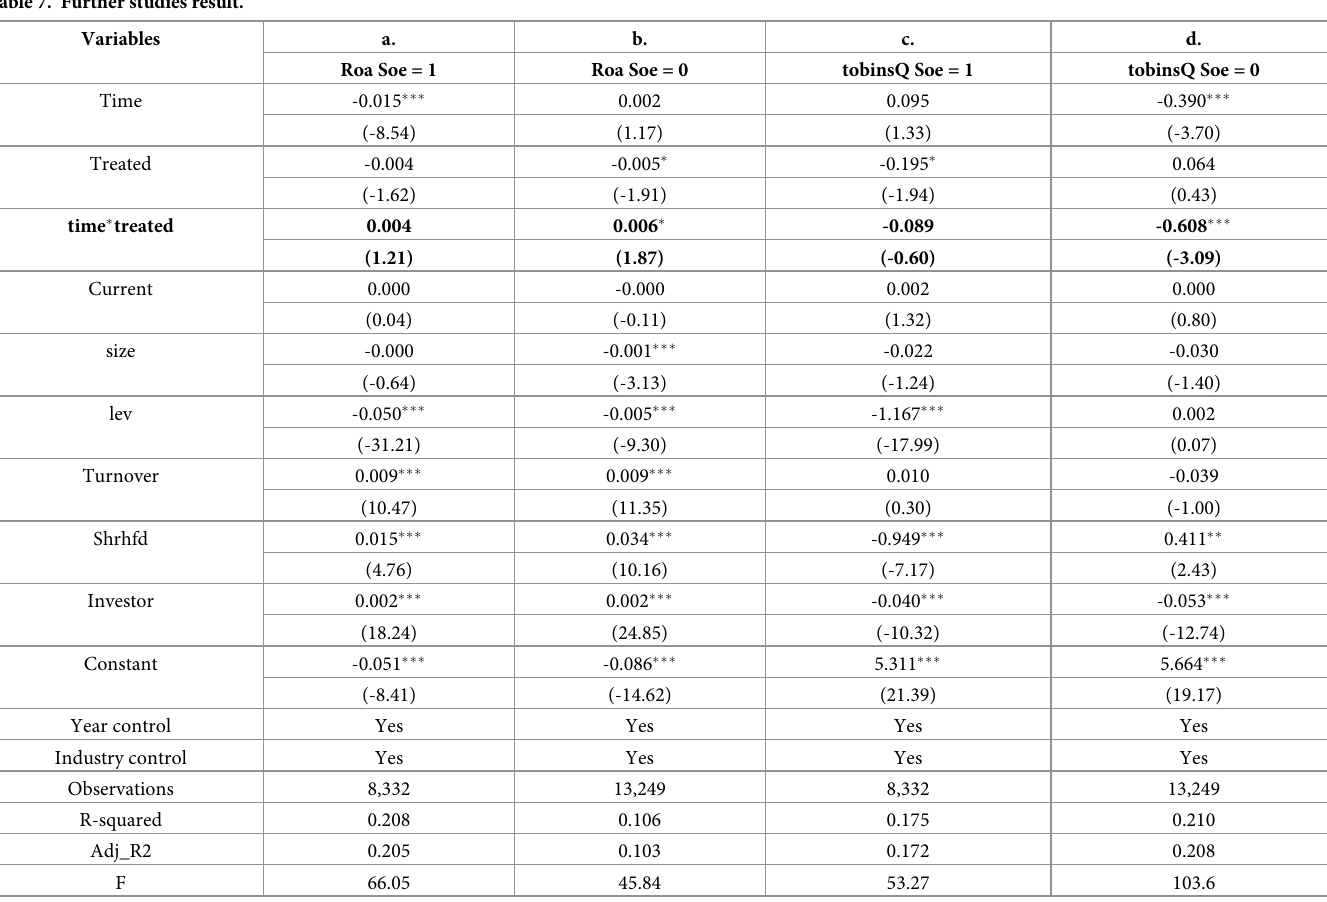
Table 7. Further studies